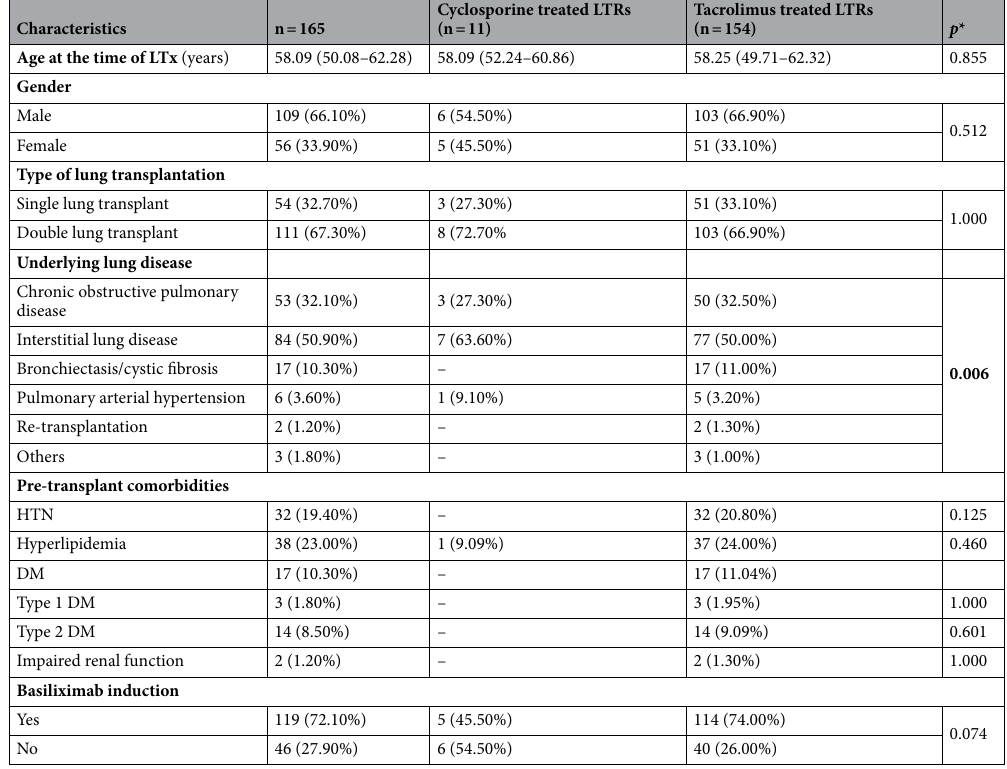
Table 1. LTRs demographic features. HTN arterial hypertension, DM diabetes mellitus, LTRs lung transplant recipients, LTx lung transplantation. *The boldface type indicates differences that are statistically significant ( p <